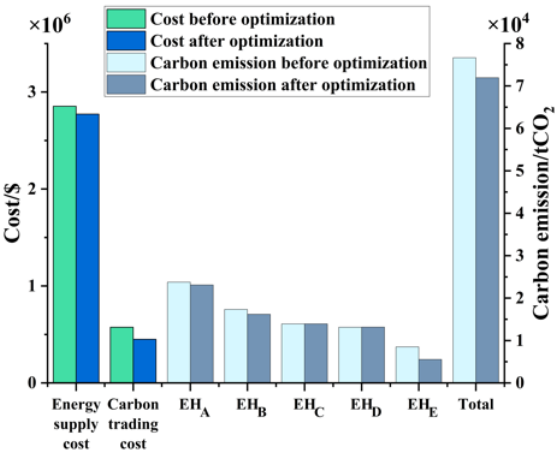
Figure 12. The energy supply cost, carbon trading cost, and carbon emissions of each EH before and after the optimization in Scenario 2.